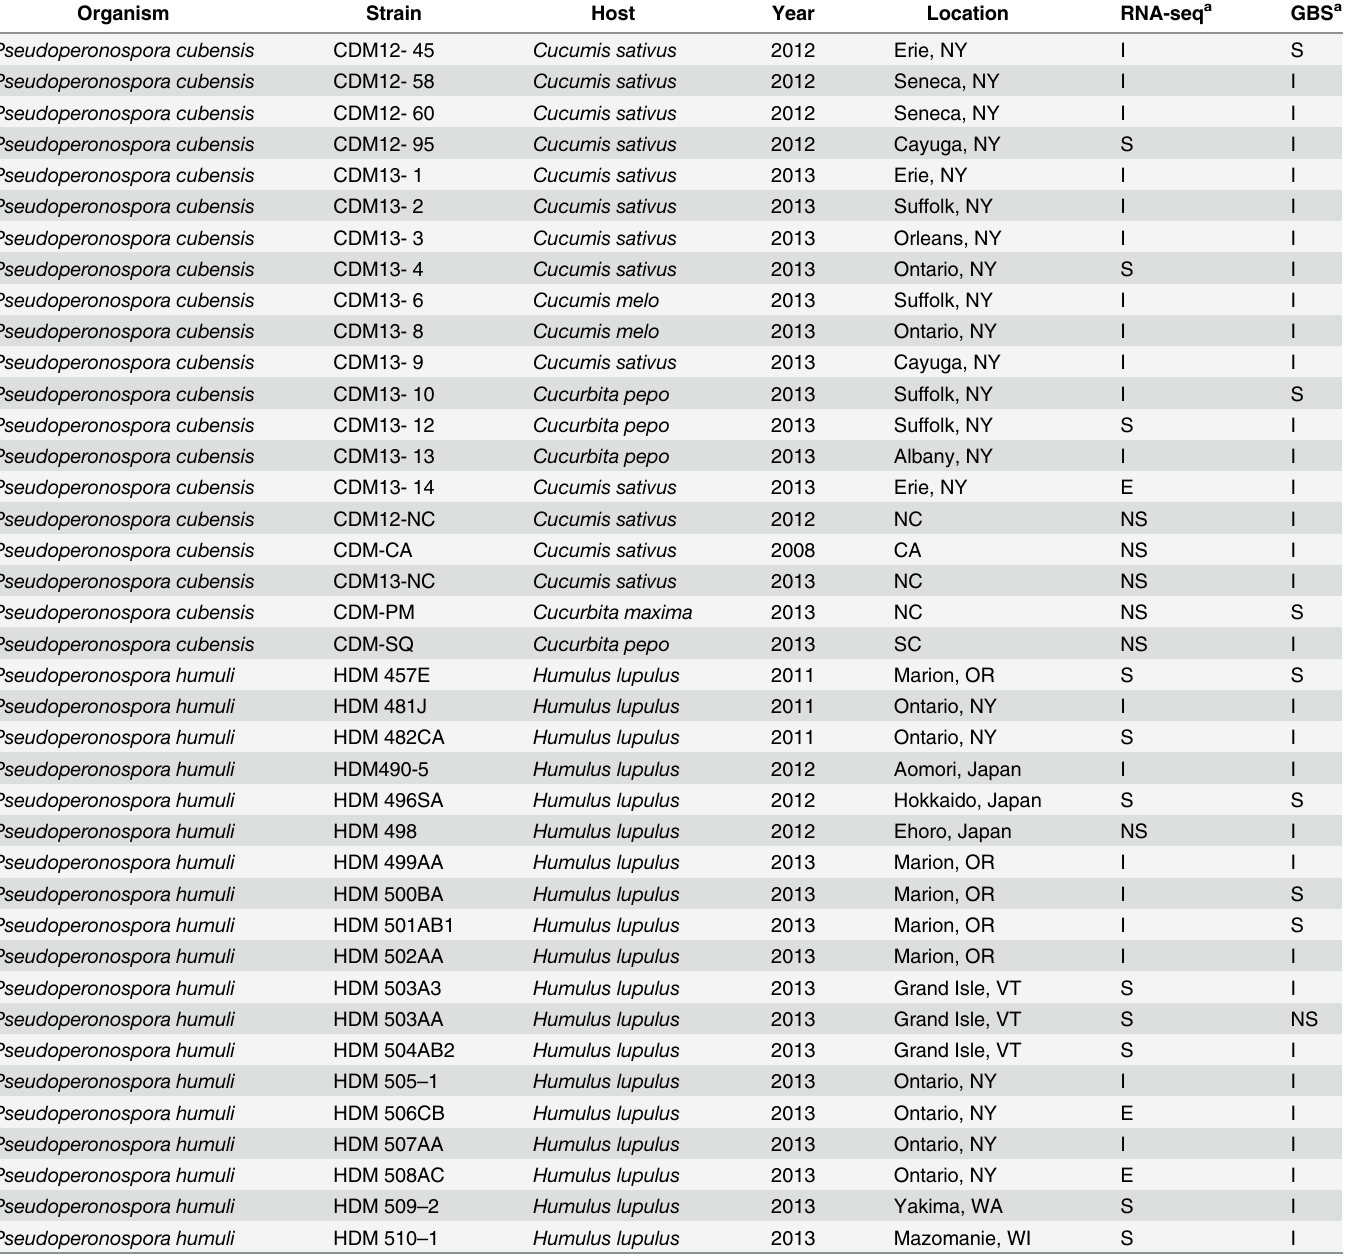
Table 1. Isolates sequenced using RNA-seq and